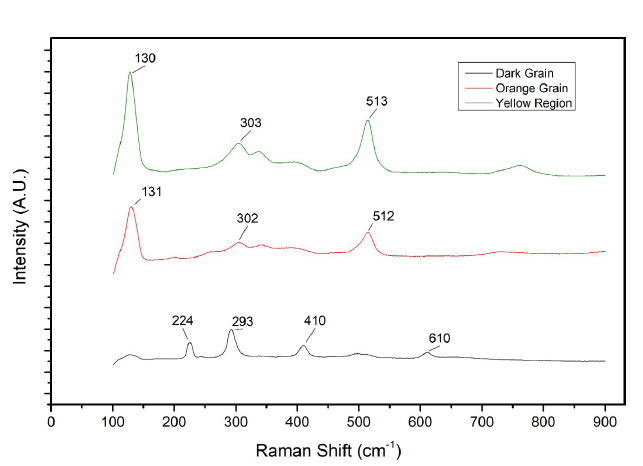
Figure 8. Comparison of recorded Raman spectra obtained from the orange region: orange grain, yellow matrix, and dark grain. The λ excitation for the dark grain spectrum was of 785 nm, while for the remaining spectra, 532